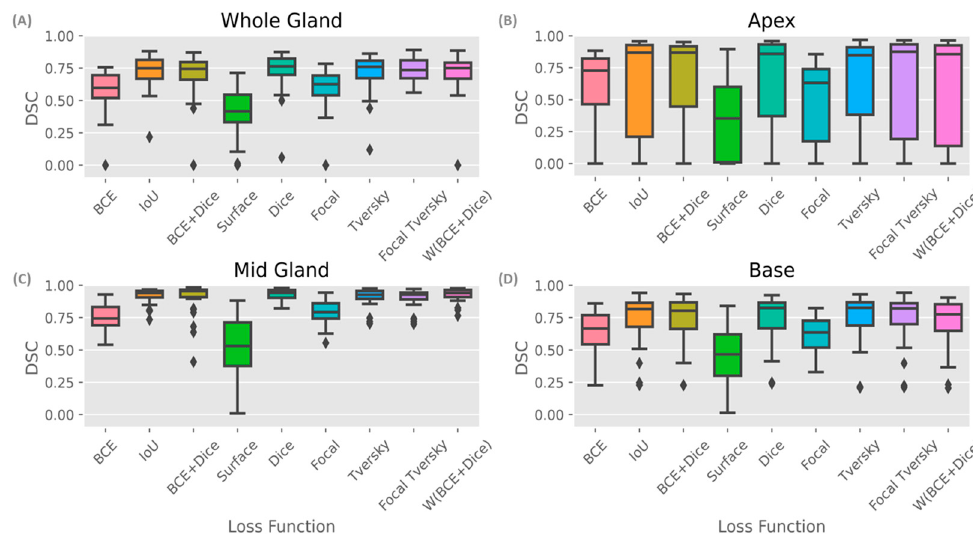
Figure 4. Boxplots showing the Dice similarity coefficient (DSC) scores for different parts of the prostate. The mid-gland ( C ) shows a consistent high performance (except for Surface loss), followed by the base ( D ) and the apex ( B ). The whole gland’s performance resembles the mid-gland ( A , C ), as it accounts for the majority of the prostate volume. Results are from the model trained using the Dice loss.